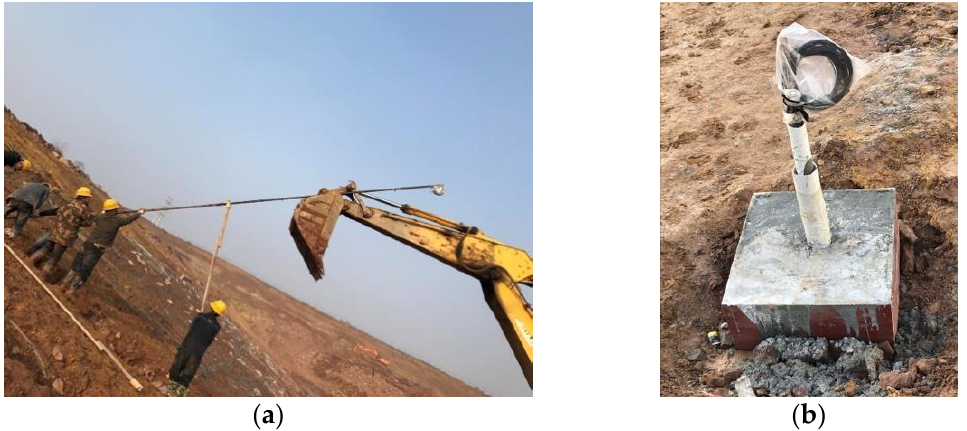
Figure 5. Bolt installation and concrete pile cap. ( a ) Bolt installation ( b ) Concrete pile cap.